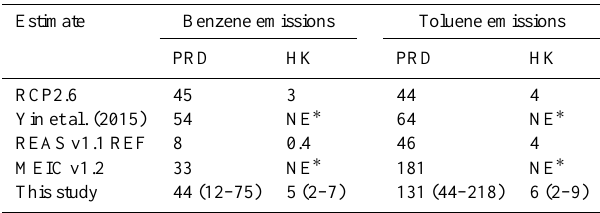
Table 2. Benzene and toluene emissions (Ggyr − 1 ) in the PRD and HK regions derived from different estimates for the year